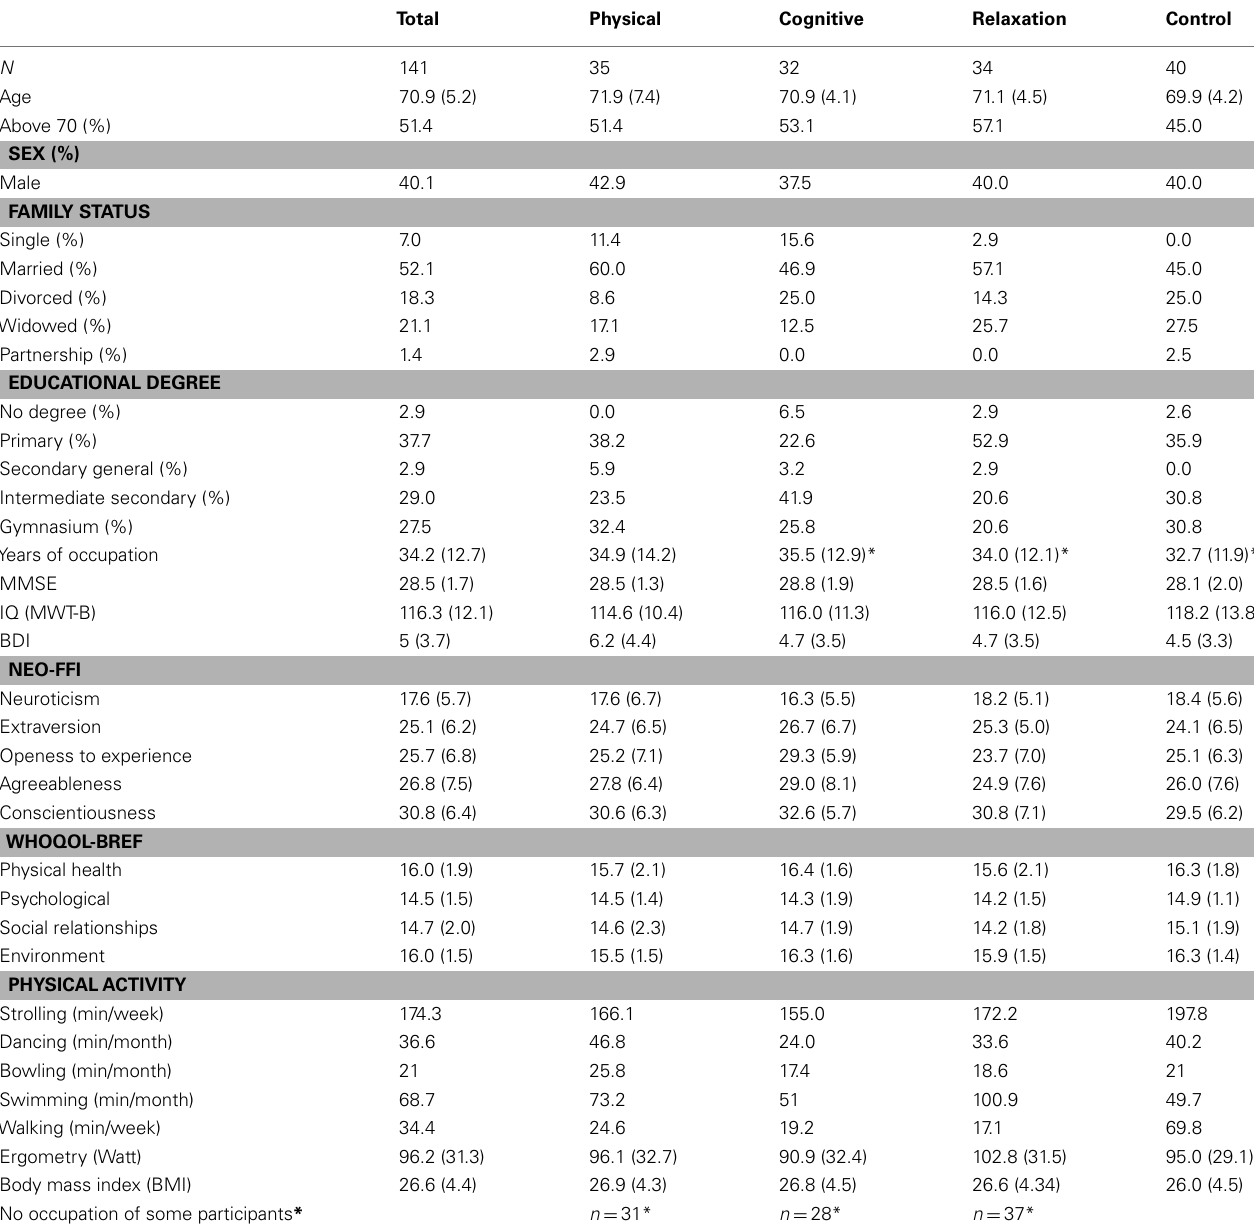
Table 1 | Socio-demographic characteristics of the whole sample and separated for each experimental (physical, cognitive) and control (relaxation, no-contact) group. Total Cognitive